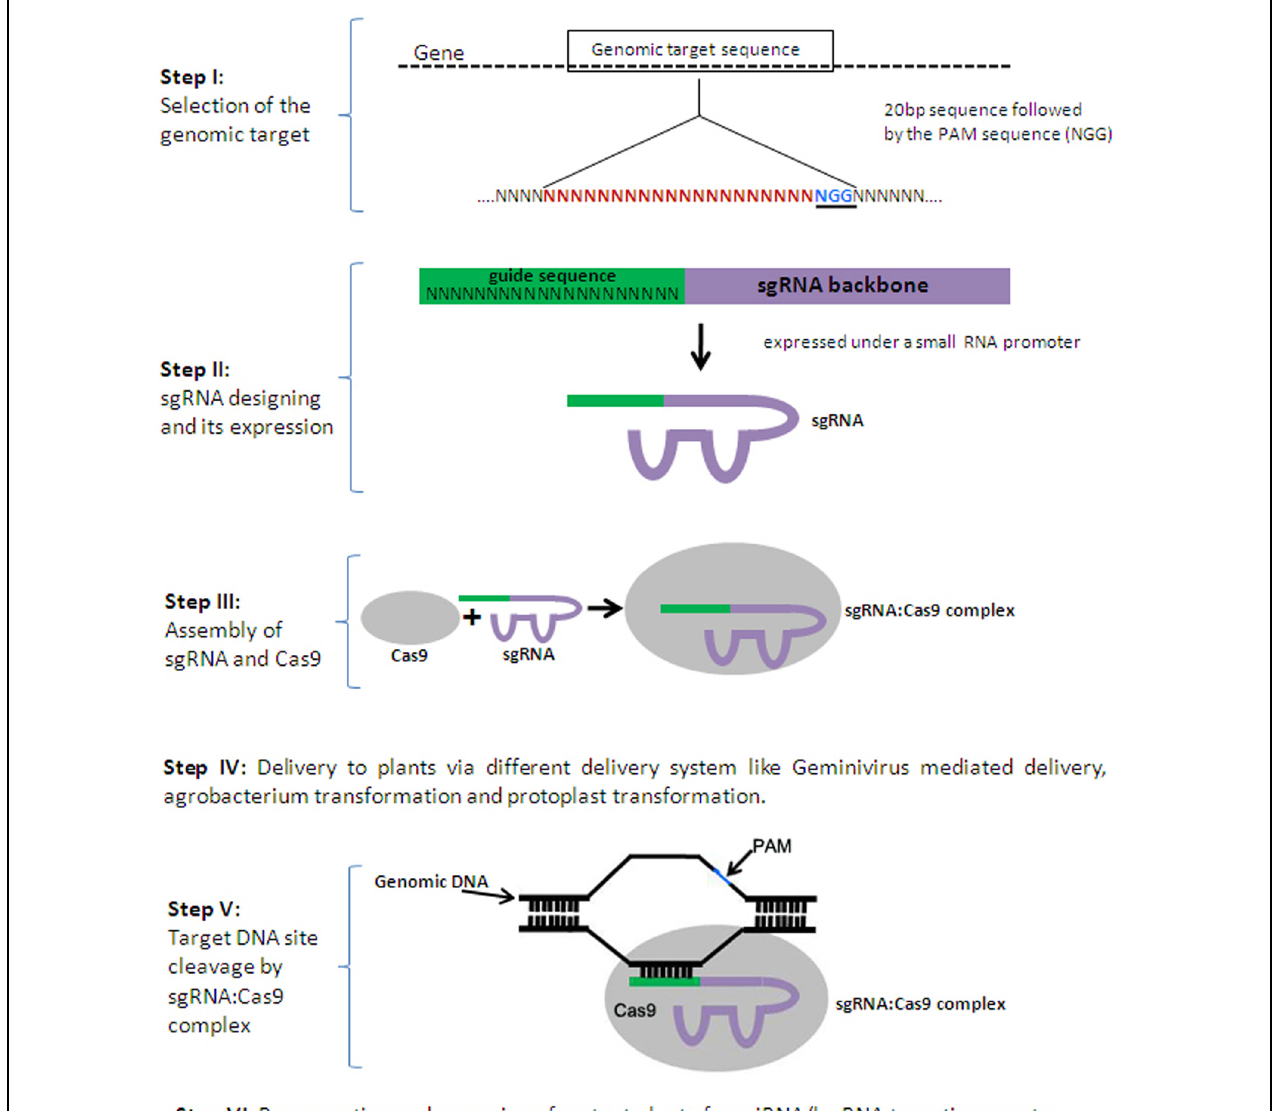
FIGURE 2 | Series of events to generate a clustered regulatory interspaced short palindromic repeats/CRISPR-associated (CRISPR-Cas) mutagenised plant. CRISPR-Cas mediated genome engineering in plants requires ‘single guide’ RNA (sgRNA) and CRISPR-associated protein 9 (Cas9). Specially designed sgRNA are expressed under a small RNA promoter and transfected along with a Cas9 expression plasmid, to form a complex which targets complementary DNA adjacent to the protospacer adjacent motif (PAM). sgRNA:Cas9 complex generates a double strand break (DSB) that may either be repaired precisely (without any effect) or imperfectly leading to a mutation (indel) in the genomic target